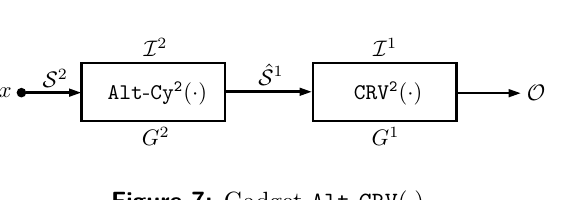
Figure 7: Gadget Alt - CRV ( · )